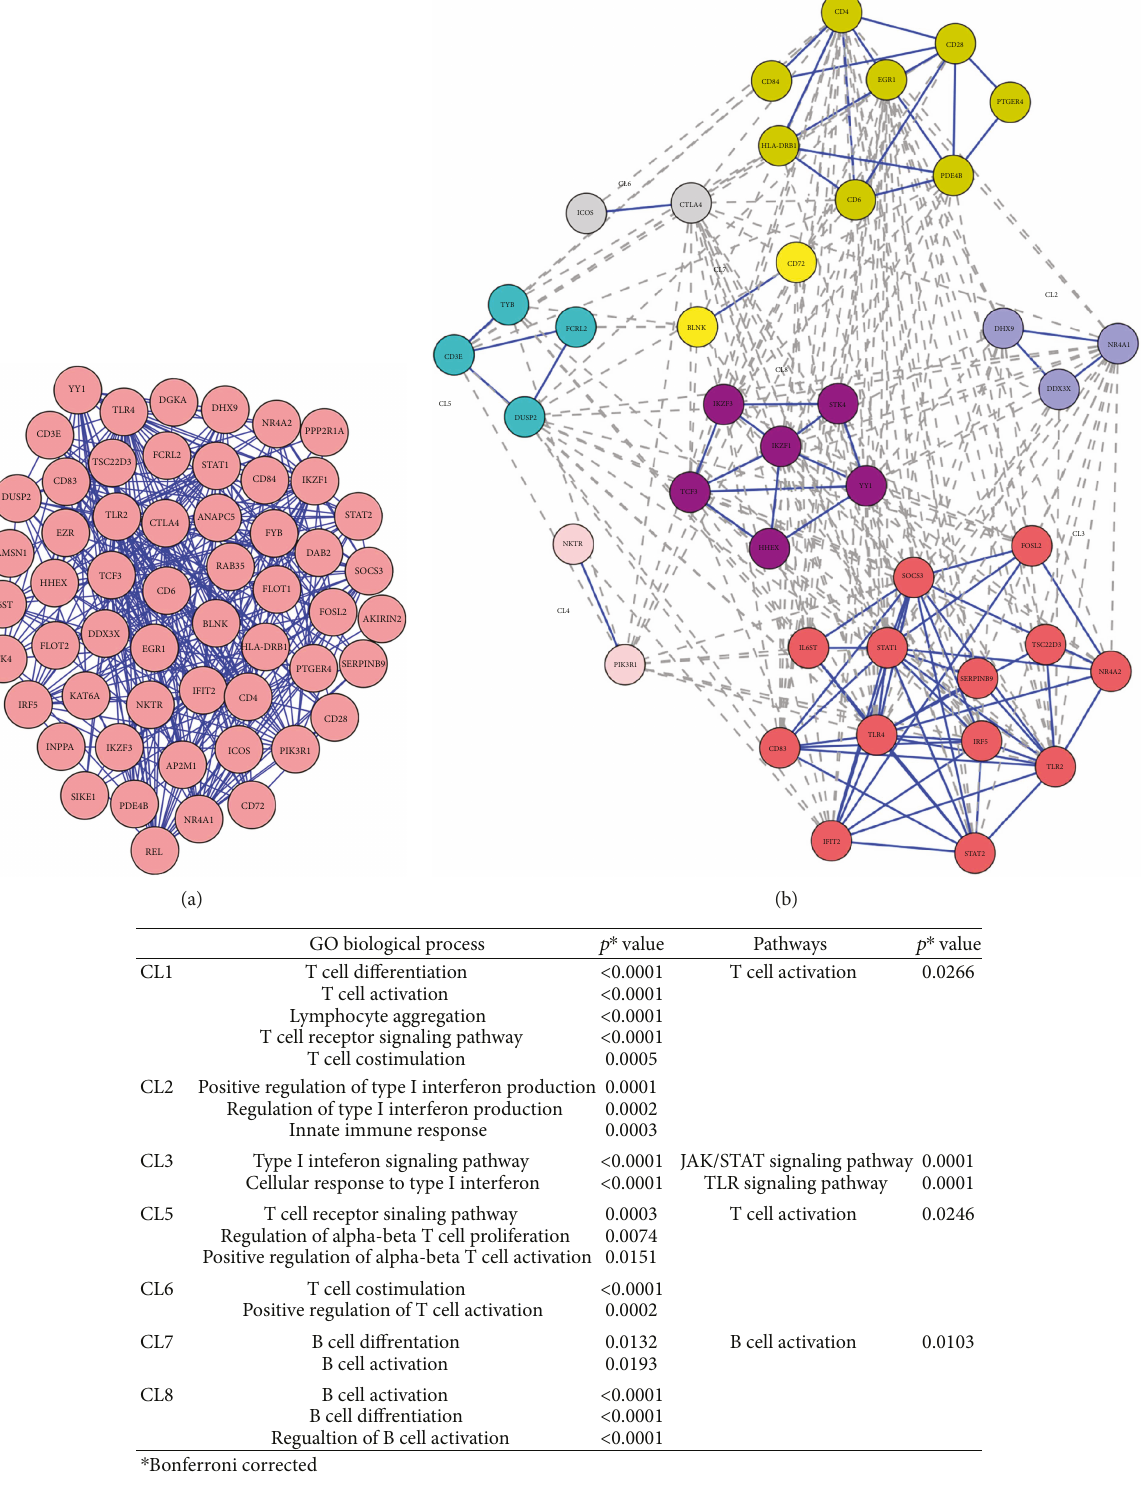
Figure 4: Network analysis of modulated genes in BD. Panel (a): PPI network of genes involved in immune response; panel (b): clusters extracted from the PPI network; panel (c): biological processes and pathways enriched in the eight